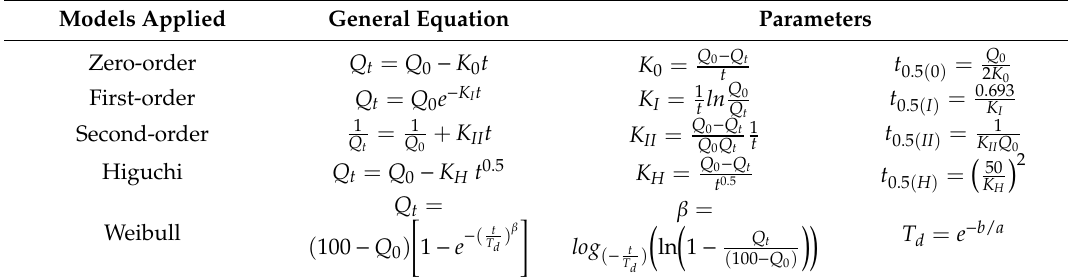
Table 2. Kinetic models applied to estimate obtained results. Q 0 is initial percentage of the released drug; Q t is percentage of the released drug after time t ; K is rate constant, for zero-order kinetics ( K 0 ), 1st-order kinetics ( K I ), 2nd-order kinetics ( K II ), and Higuchi model ( K H ), respectively; Td is time after release of 69.3% of drug from the formulation; t 0.5 is half release time; β is a shape parameter in the Weibull model; a , b , are slope and intersection of the graph representing the release process, respectively. Models Applied General Equation